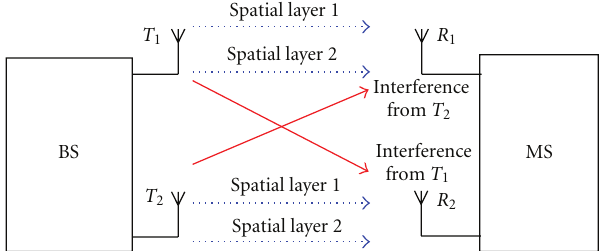
Figure 1: Example of self-interference in a 2 × 2 SM transmission.